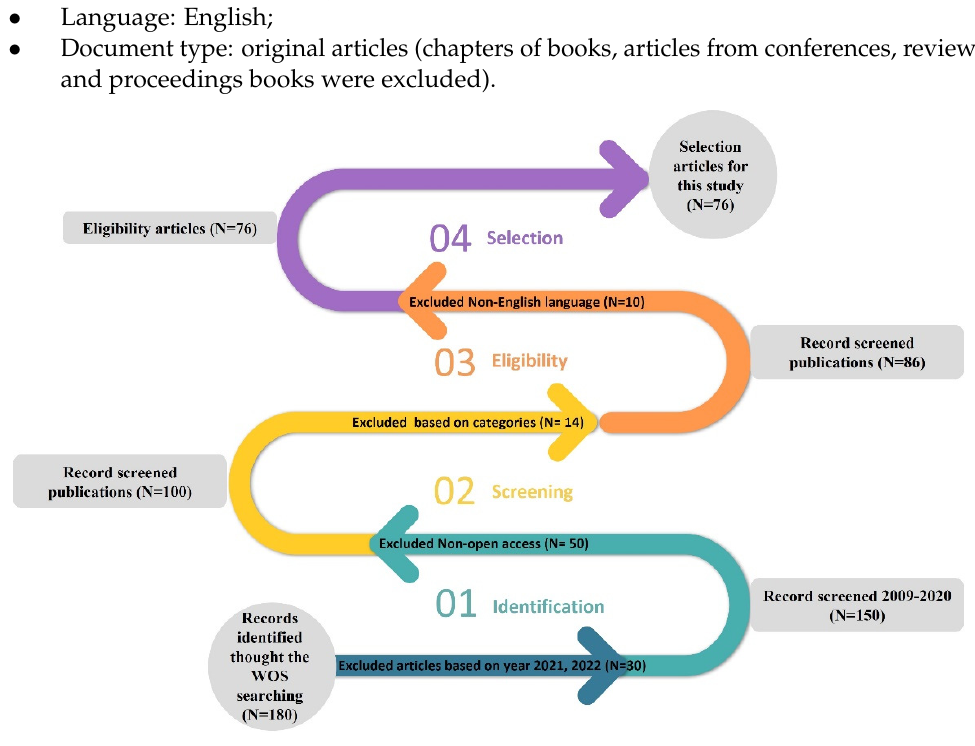
Figure 1. PRISMA protocol to extract empirical articles for this systematic study.